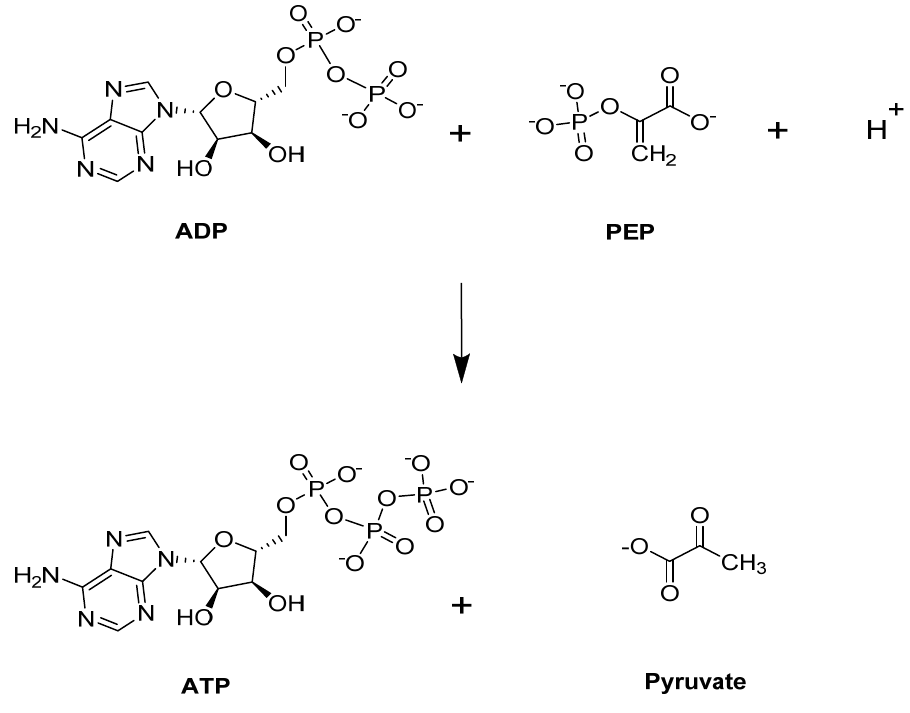
Figure 3. PKR-catalyzed